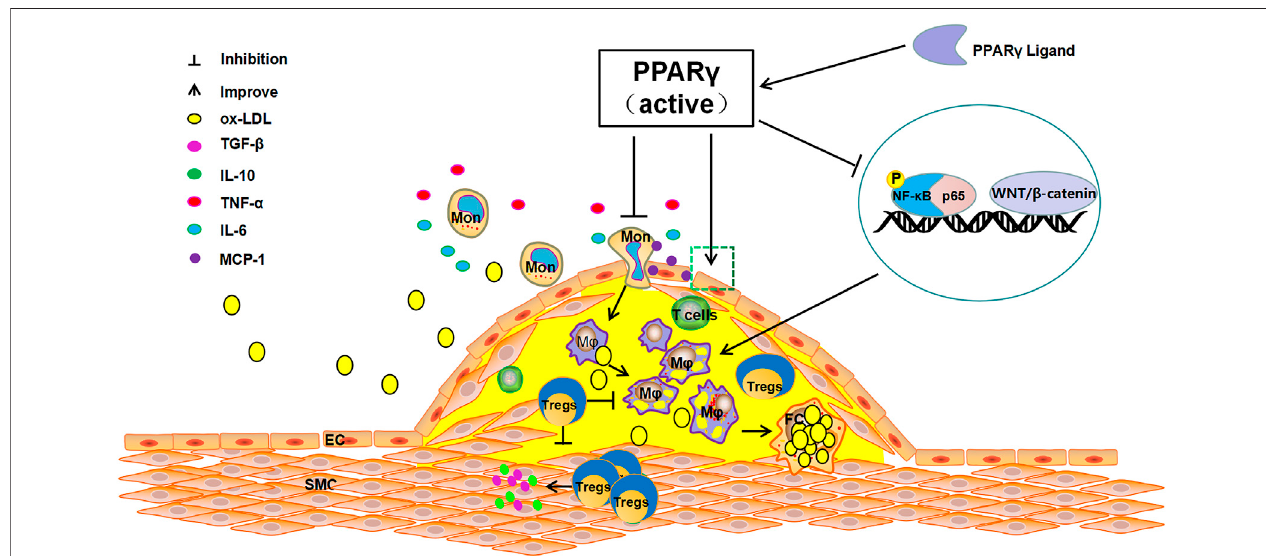
FIGURE1| Theanti-atherosclerosispathwaysofPPAR γ .TheactivationofPPAR γ canrecruitTregstoimproveendothelialfunction,inhibitthereleaseofTNF- α ,IL- 6, and other in fl ammatory cytokines, reduce the production of MCP-1, suppress the differentiation of monocytes to macrophages and foam cells. In contrast, PPAR γ activation can directly inhibit NF-KB phosphorylation or can indirectly inhibit the activation of NF-KB by competitively binding p65 to reduce the production of pro- in fl ammatory cytokines and restrain